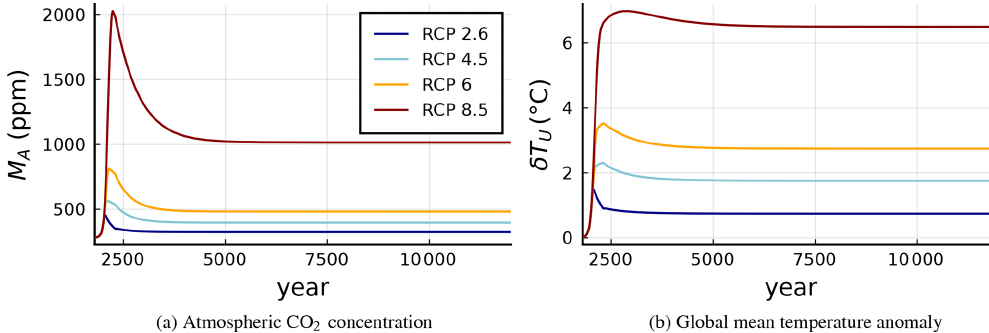
Figure 15. SURFER’s long-term prediction when forced by extended RCP scenarios.